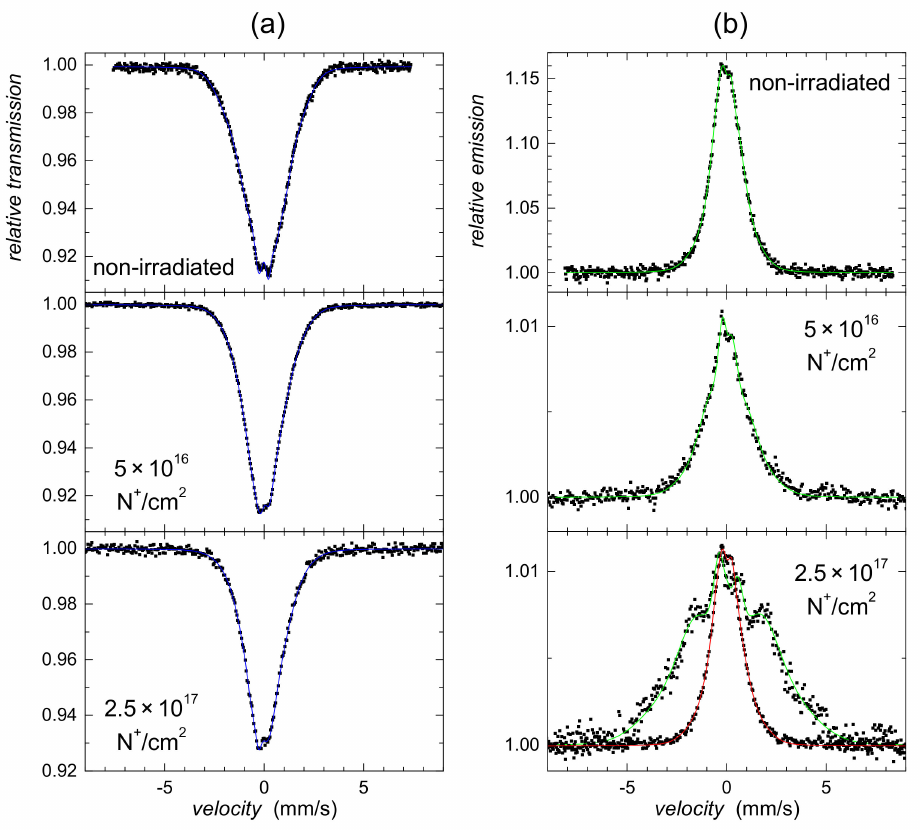
Figure 3. Mössbauer spectra of Fe 76 Mo 8 Cu 1 B 15 amorphous metallic alloy irradiated by 130 keV N + ions with the indicated fluences: ( a ) Transmission geometry (blue); ( b ) CEMS (green). The Mössbauer spectrum taken from the wheel side of the ribbons is shown for comparison in ( b )